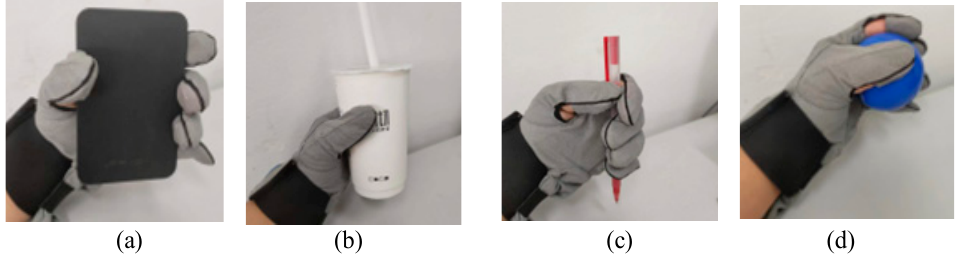
Figure 11. Grasping training effect. ( a ) Finger grasping square box; ( b ) Finger grasping milk tea; ( c ) Finger grasping pen; ( d ) Finger grasping the ball.